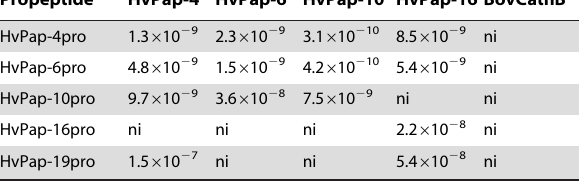
Table 1. Inhibition constants ( K i ) values of the barley propeptides (HvPap-4pro, -6pro, -10pro, -16pro, -19pro) against barley cathepsin L-like (HvPap-4, -6, -10, -16)